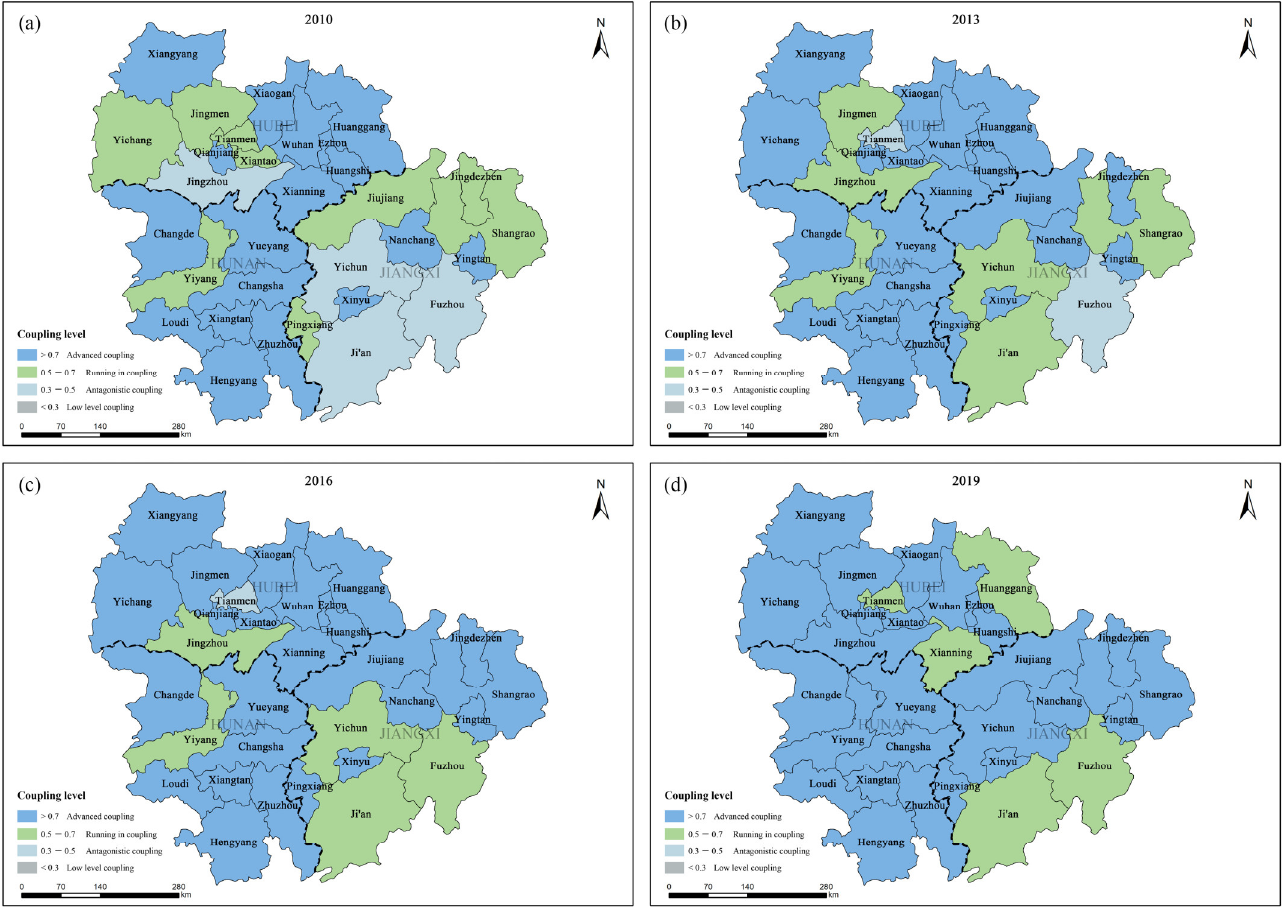
Figure 7. Spatial distribution of coupling level of 31 cities in: ( a ) 2010; ( b ) 2013; ( c ) 2016; ( d ) 2019.